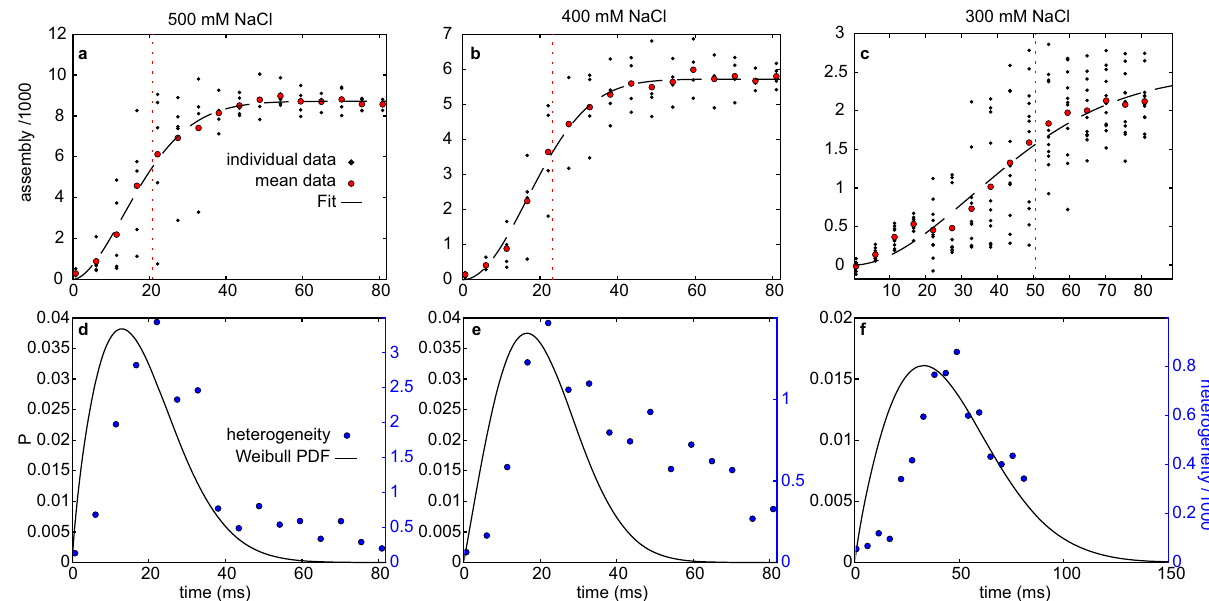
Fig. 7 The quench depth determines nucleation and assembly rate. a – c Assembly metric calculated from the SAXS structure factor as a function of time for different quench depths (i.e., NaCl concentrations). Black dots are individual measurements, and red circles are the average of all measurements at each time point. The black dashed line is a fi t to a scaled Weibull cumulative probability distribution. The horizontal red dotted line shows the mean of the related PDF. d – f Fit to the Weibull distribution transformed into a probability density distribution. The blue circles are the standard deviation of the distribution of individual data points in a – c .